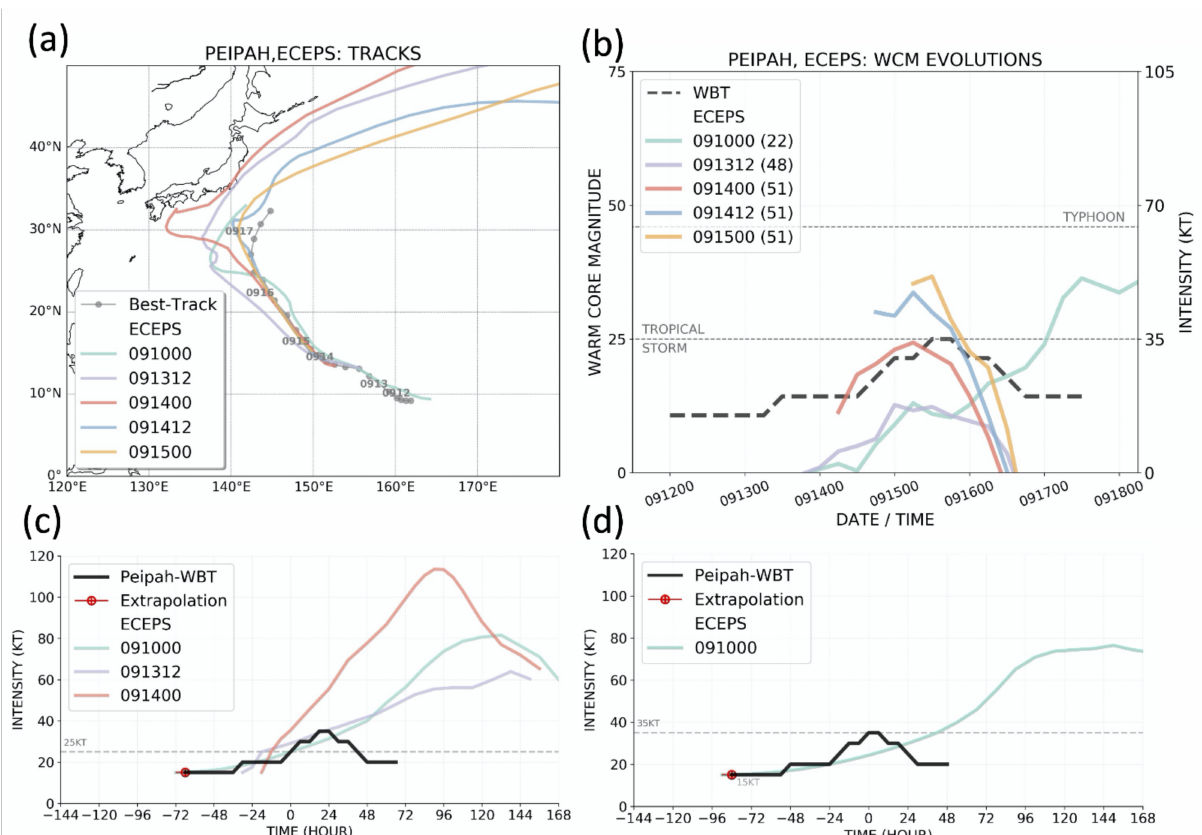
Figure 9. ( a ) Sequence of ECEPS WMVM track forecasts as in Figure 1a, except for pre-TS Peipah with a T2F (25 kt) of 18 UTC 14 September and a T2F (35 kt) of 12 UTC 15 September and an ending time of 12 UTC 17 September near 32 ◦ N, 145 ◦ E. Note that there is a 3.5 day gap between the first track forecast from 00 UTC 10 September which ended near 34 ◦ N, 142 ◦ E, and the second track forecast from 12 UTC 13 September, which recurved near 30 ◦ N, 137 ◦ E and then passed near the coast of Japan. ( b ) ECEPS-predicted Warm Core Magnitude evolutions as in Figure 1b except for pre-TS Peipah that had JTWC WBT intensities (kt, black dashed line, right ordinate). Pre-TS Peipah circulation modified WAIP intensity (knots) forecast verifications for the ECEPS-predicted T2F (25 kt) in panel ( c ) and T2F (35 kt) in panel ( d ), and the JTWC WBT intensities are in the black lines. Note that only the first ECEPS forecast from 00 UTC 10 September had a WCM exceeding the Tropical Storm threshold in panel ( b ) that triggered a T2F (35 kt) WAIP intensity prediction in panel ( d